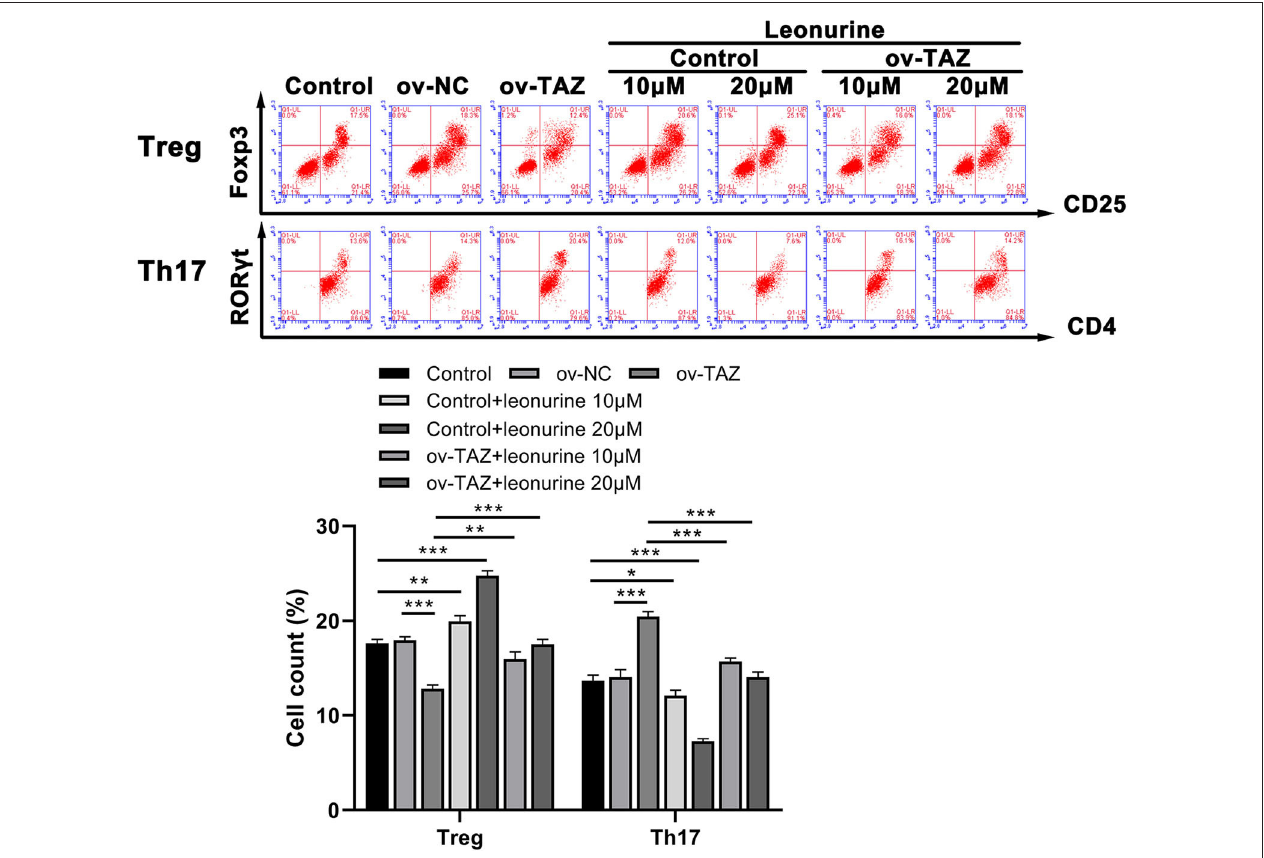
FIGURE 3 | Flow cytometry results showed that the frequency of Treg cells (expressing Foxp3) in the ov-TAZ group was lower than that in the ov-NC group, whereas the frequency of Th17 cells (ROR γ t expressing) in the ov-TAZ group was higher than that in the ov-NC group. When leonurine was added, it increased the Treg cell frequency and decreased that of Th17 cells. Furthermore, leonurine increased Treg cell frequency in the ov-TAZ group and decreased that of Th17 cells. Results are expressed as average of 3 experiments. * P < 0.05, ** P < 0.01, and *** P <